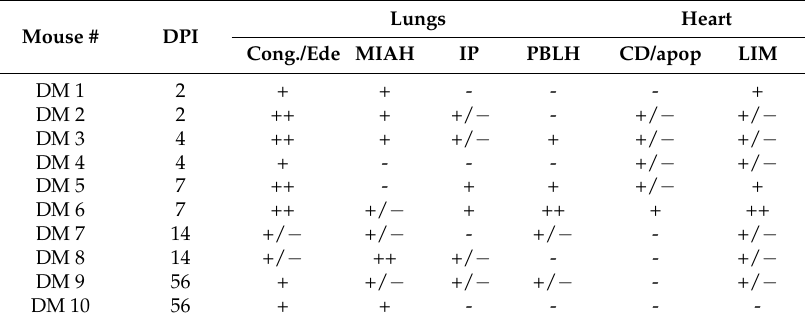
Table 1. Histopathology of deer mice infected with Maporal virus.